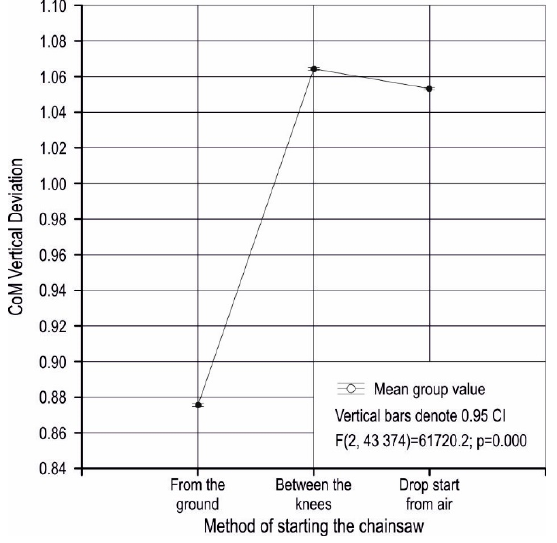
Figure 3 . The CoM vertical deviation (m) versus three methods of starting a chainsaw Figure 3. The CoM vertical deviation (m) versus three methods of starting a chainsaw.